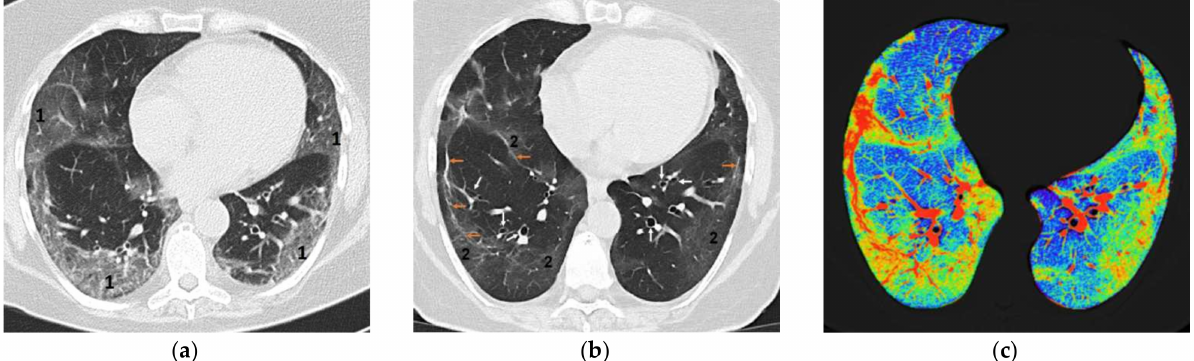
Figure 1. ( a ) Bilateral pneumonia with preponderant peripheric topography of inflammatory in- filtrates ( 1 ); ( b ) bilateral fibrosis with linear ( orange arrows ) and “ground glass” pattern ( 2 ) and bronchiectasis images ( white arrows ); ( c ) bilateral fibrosis with color encoding (green—“ground glass fibrosis and thin reticular fibrosis; orange—linear fibrosis, blue—normal lung densities).